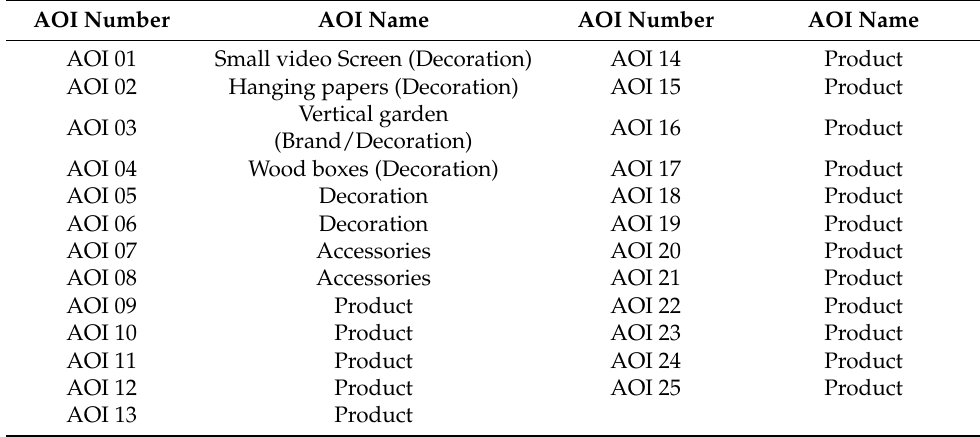
Table 2. Footwear store area. Areas of Interest and